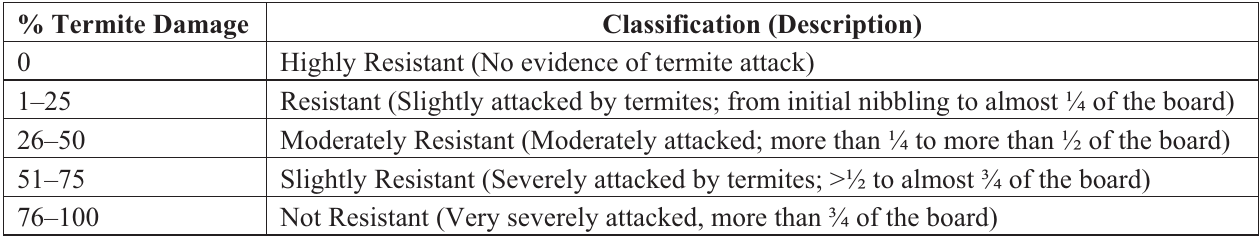
Table 1. Termite-resistance